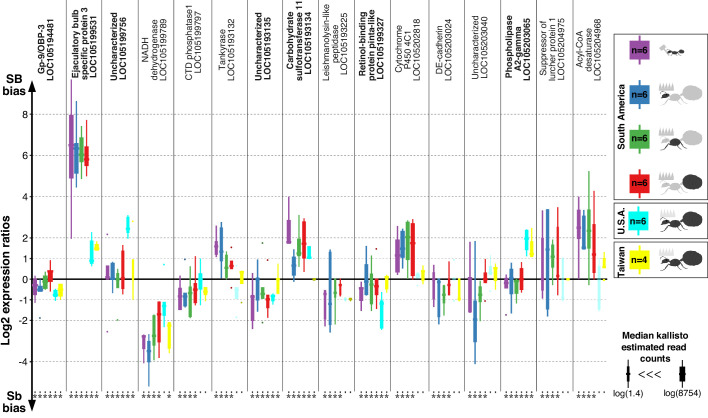
Differences in expression levels between alleles for genes in the fire ant social supergene in heterozygous SB/Sb individuals which exist only in multiple-queen colonies.Differences in expression (y axis) between social chromosome variants in whole bodies of workers from South America, heads, thoraces and abdomens of queens from South America, whole bodies of queens from North America and Taiwan. We show all 16 genes with significant allelic bias in South American populations, and the corresponding biases from the other populations. Bold gene names highlight when allelic bias occurs in all populations (Benjamini-Hochberg (BH) adjusted p<0.05 from the joint linear mixed-effects model). Significance in population-specific comparisons is indicated by an asterisks under each boxplot (BH adjusted p<0.05 from either the joint analysis or DESeq2 Wald tests). Each box shows the distribution of logarithm two expression ratios between SB and Sb in each sample type. Positive values indicate higher SB expression; negative values indicate higher Sb expression. A log2 expression ratio greater than one or smaller than −1 represents a two-fold gene expression difference in either direction. Genes are in chromosomal order.Figure 1—source data 1.Differences in expression levels between alleles for genes in the fire ant social supergene in heterozygous SB/Sb individuals which exist only in multiple-queen colonies.The columns in the dataset stand for: refseq_id, gene ID in the RefSeq database; body_part, body part from which the RNA was extracted; median_expression, median DESeq2 normalized expression per gene across all samples per body part; mean_lfc, mean log2 fold changes between Sb and SB allelic expression per body part; sd_lfc, standard deviation of the log2 fold changes between Sb and SB allelic expression per body part; littleb_expression, DESeq2 normalised read counts for the Sb allele, bigB_expression, DESeq2 normalised read counts for the SB allele; sample_id, ID for the replicate; population, population of origin of the replicate, total_expression, combined SB Sb expression per gene per replicate; lfc_SB-Sb, log2 fold changes between SB and Sb DESeq2 normalized read counts; normalized_lfc, Z scores centered log2 fold changes between SB and Sb, the mean log2 fold change per body part is substracted from the log2 fold change per gene per replicate and divided by the standard deviation per body part; significant, whether a gene show significant differences in expression levels between Sb and SB according to either our linear mixed effects model or DESeq2's Wald test, "na" for significance in North American populations, "sa" for South American, "taiwan" for Taiwanese populations and "all" if a geneis significant in all populations.